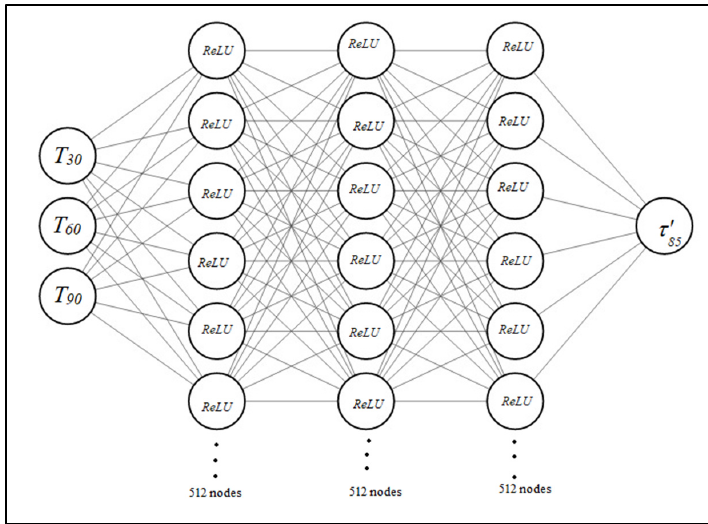
Figure 6. Topology of the MLP network used in this study.